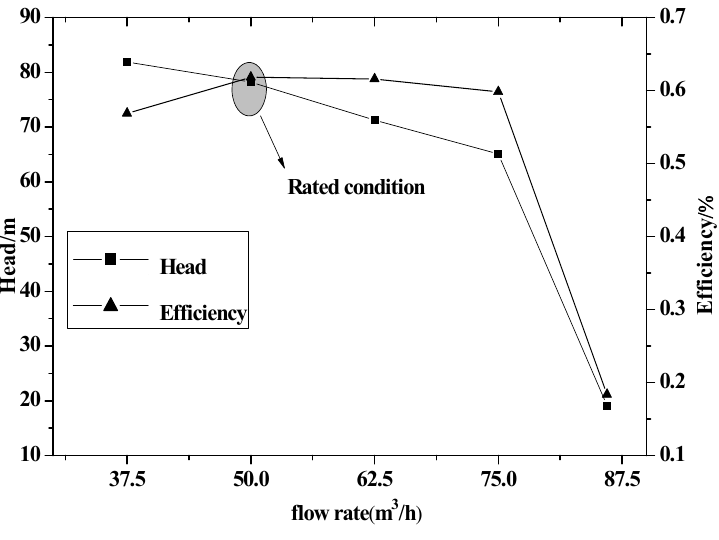
Figure 13. Head and efficiency changing curve with flow rate (2900 rpm).